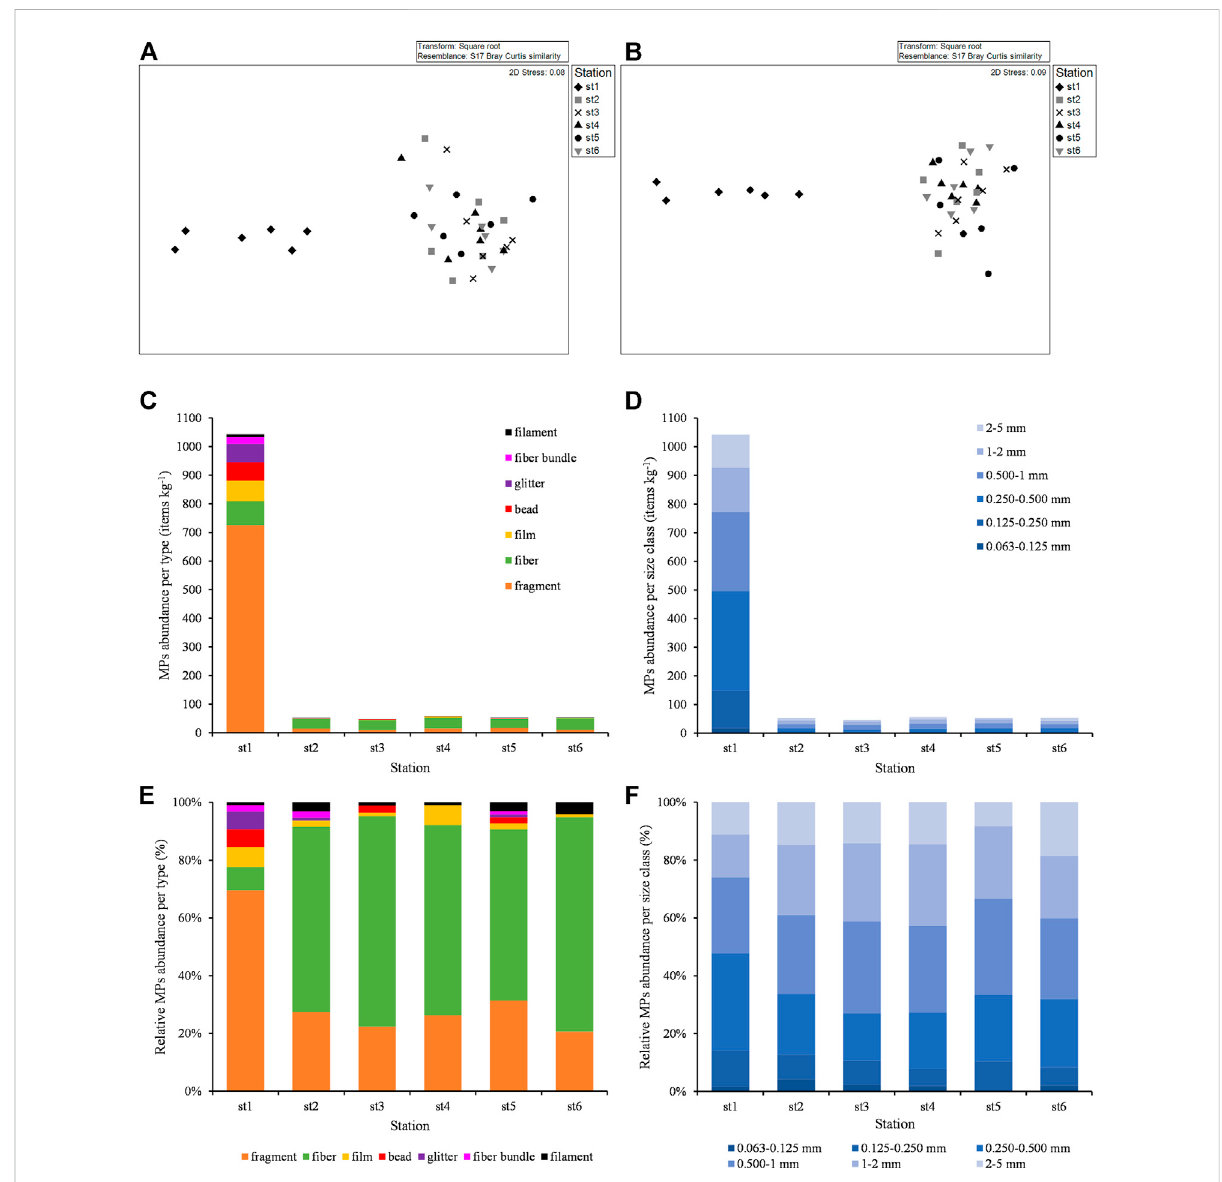
FIGURE 6 Multidimensional scaling plot based on the Bray-Curtis distance between samples of the different stations according to type of MPs (A) and to MPs size class (B) . Spatial variation of mean MPs abundance (items kg − 1 ) per particle type (C) and per size class (D) . Relative proportion of particle types, per station (E) . Relative distribution of particles size class, per station (F)